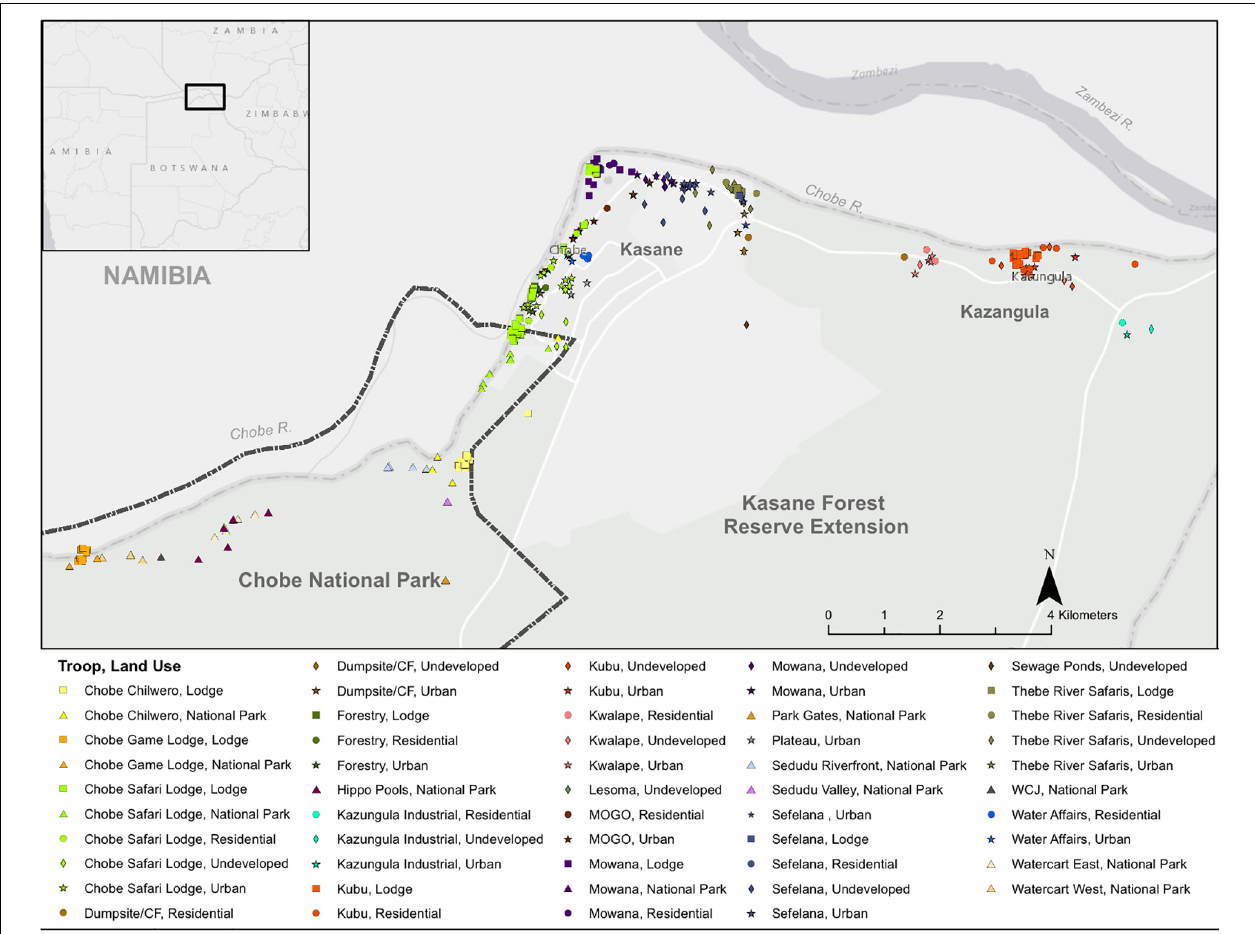
FIGURE 1 | Study Site. The study was conducted in Northern Botswana. Banded mongoose troops occurred along the Chobe River in the riparian areas backed by the Chobe Forest Reserve (dark green boundary and stipple) and Chobe National Park (light green). Banded mongoose den sites are colored by the troop ( n = 15) that used the site and the symbol provides the land type where the den was located. Lodge sites occurred within both the protected and unprotected landscapes (solid